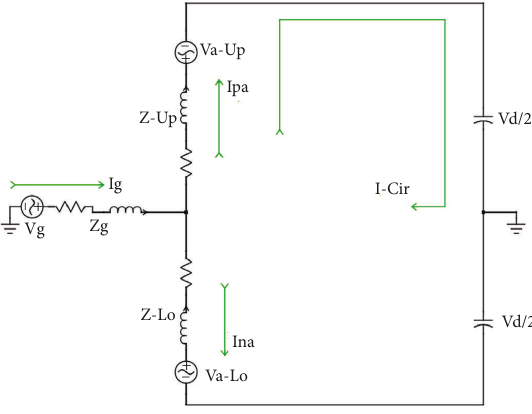
Figure 4: Equivalent circuit of phase arm of